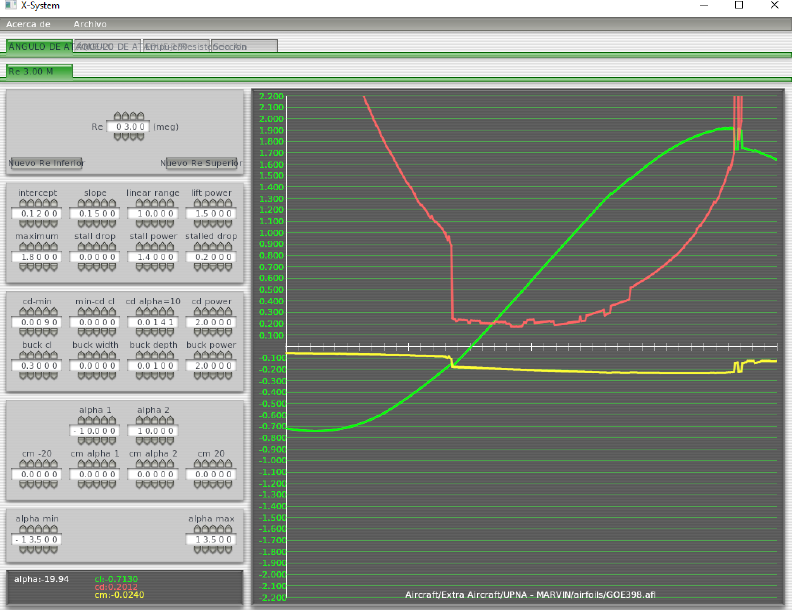
Figure 2. X-Plane’s Airfoil Maker screenshot featuring manually-adjusted aerodynamic coefficient curves of an